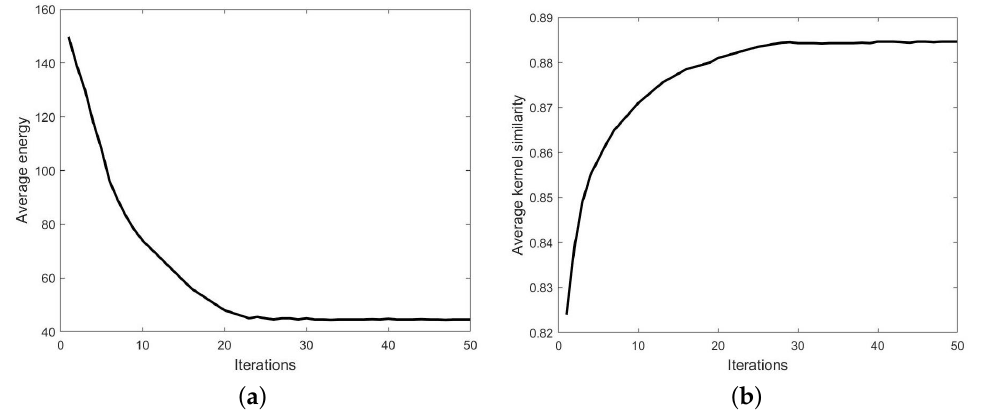
Figure 14. Convergence analysis of the proposed algorithm. ( a ) Energy value computed from Equation (8). ( b ) Average kernel similarity [53] becomes higher with more